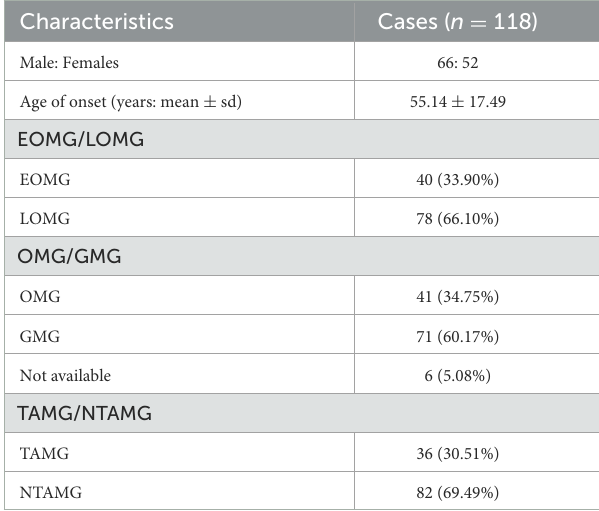
of them ( n = 36) were diagnosed to be TAMG (Table 1). In total, 18.64% of MG patients ( n = 22) had T2DM.